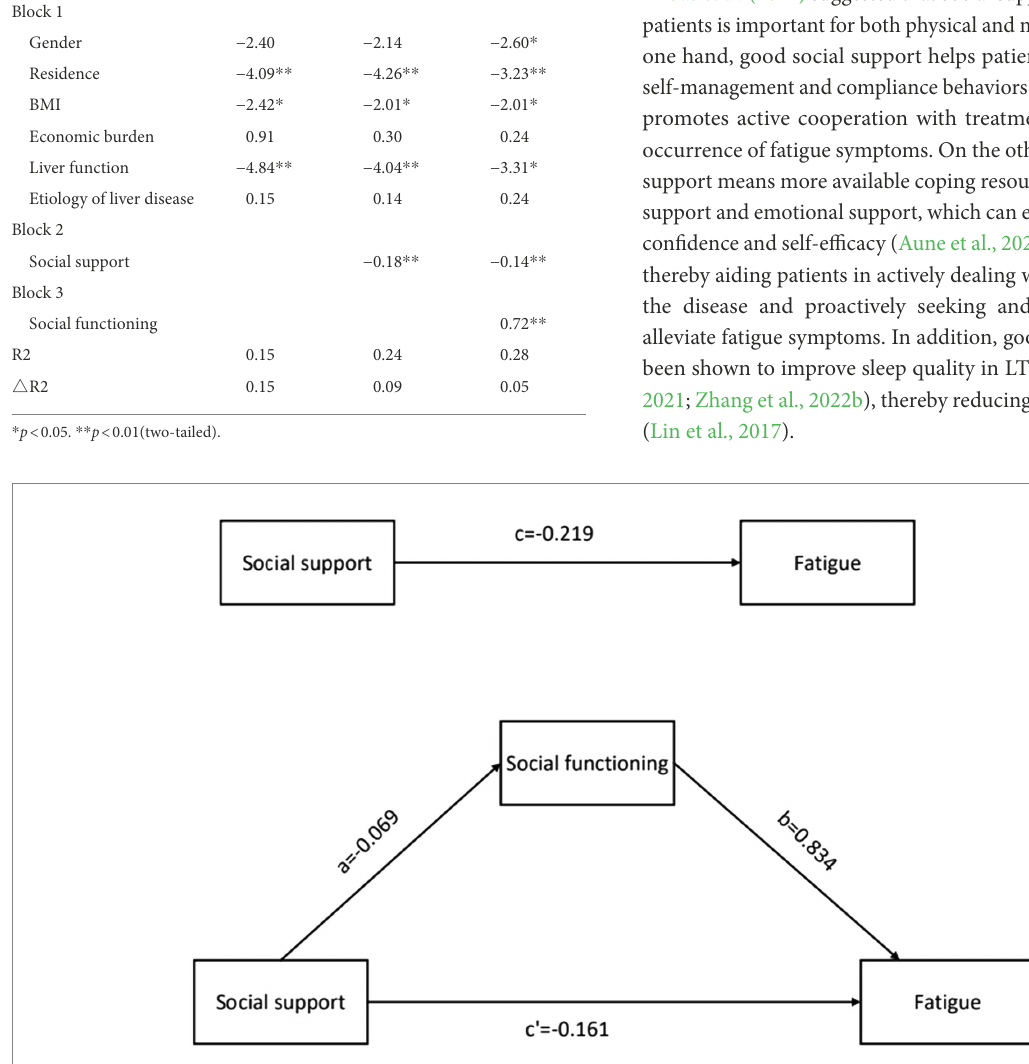
FIGURE 1 The hypothesised mediation model relating the effect of social support on fatigue through social functioning. Indirect effect of social support on fatigue through social functioning = −0.057 ( p < 0.01, 95% confidence interval, −0.105 to